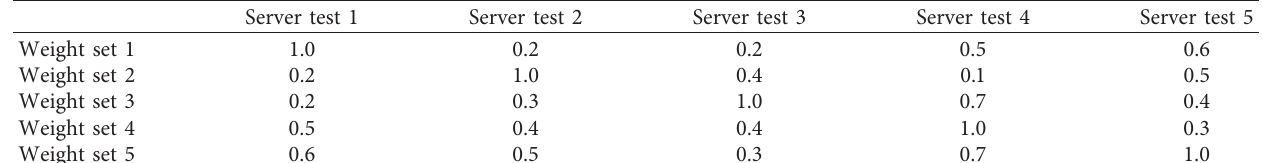
Table 1: Description of intelligent analysis of website information.